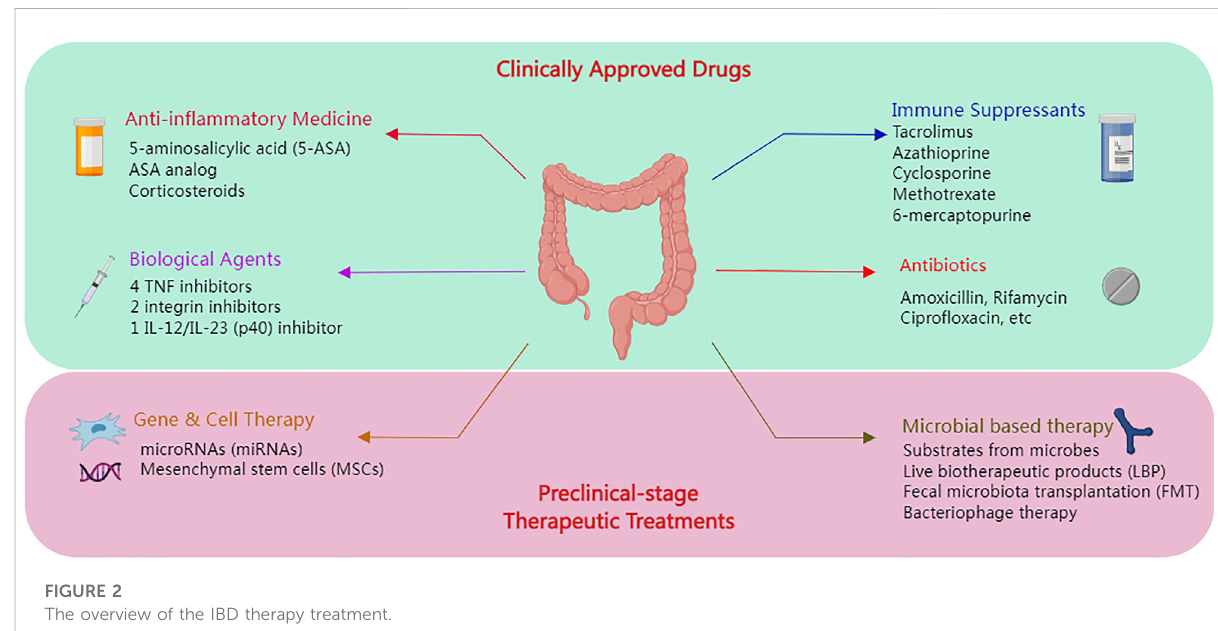
FIGURE 2 The overview of the IBD therapy